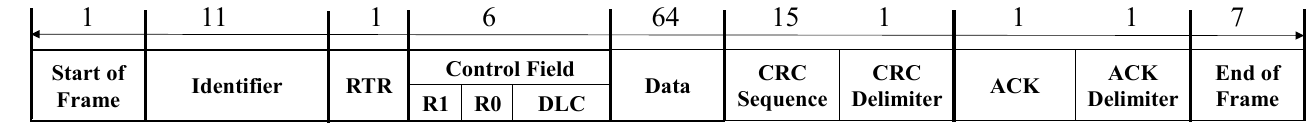
Figure 1. Standard format of a CAN 2.0A frame where the marked number indicating the length of each field is shown in bits.